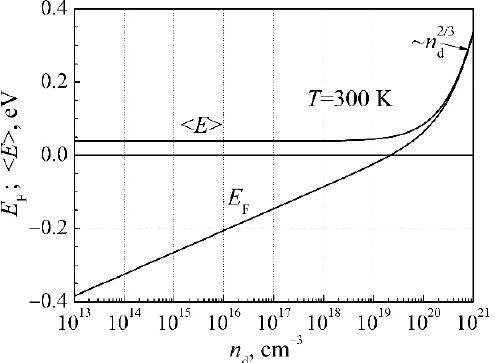
Figure 6. The Fermi level energy E F and average kinetic energy < E > of the free RM electron depend- ences on the donor density. dences on the donor